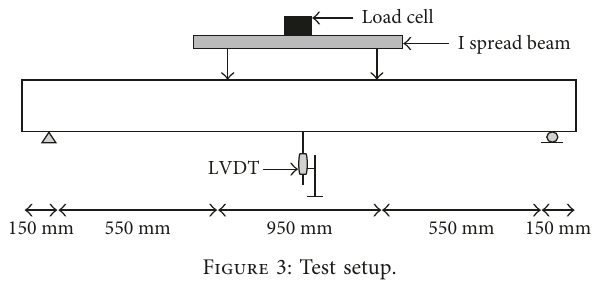
Figure 3: Test setup.